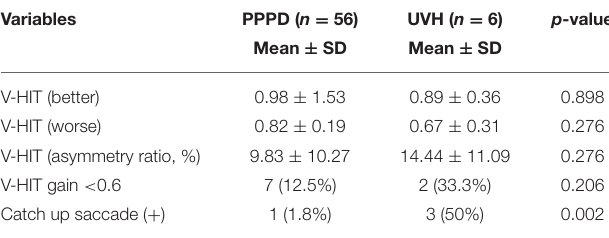
TABLE 2 | V-HIT results for PPPD and